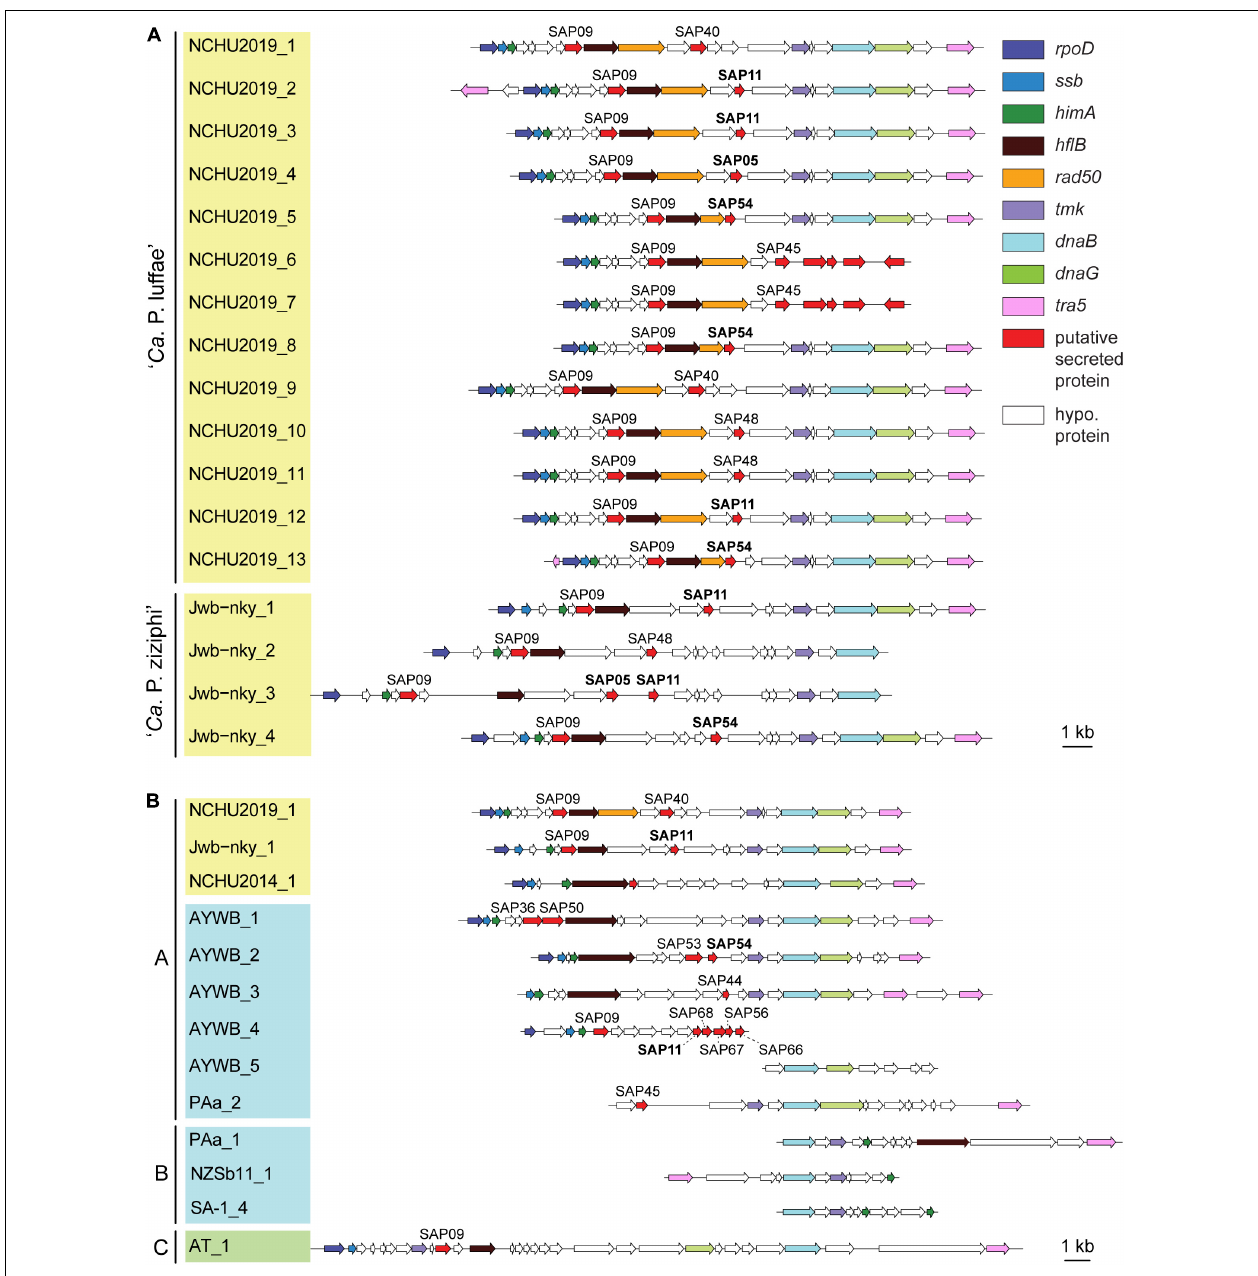
FIGURE 5 | Gene organization of potential mobile units (PMUs). Each individual PMU is labeled by the phytoplasma strain name and a numerical identifier. Background colors for the PMU identifiers indicate the three phylogenetic clusters of phytoplasmas (I: blue; II; green; III: yellow). Genes are drawn to scale and color-coded according to annotation. Homologs of putative effectors identified in the ‘ Ca . P. asteris’ AYWB genomes are labeled, those with experimental evidence (i.e., SAP05, SAP11, and SAP54) are highlighted in bold. Detailed information regarding the coding sequences in these regions is provided in Supplementary Table 2 . (A) All PMUs in ‘ Ca . P. luffae’ NCHU2019 and ‘ Ca . P. ziziphi’ Jwb-nky. Grouped by genomes. (B) Representative PMUs from selected phytoplasmas. Grouped by PMU